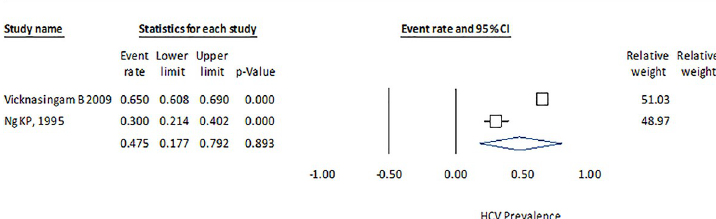
Fig 5. Forrest plot of random effects model to estimate HCV prevalence in IDU population in